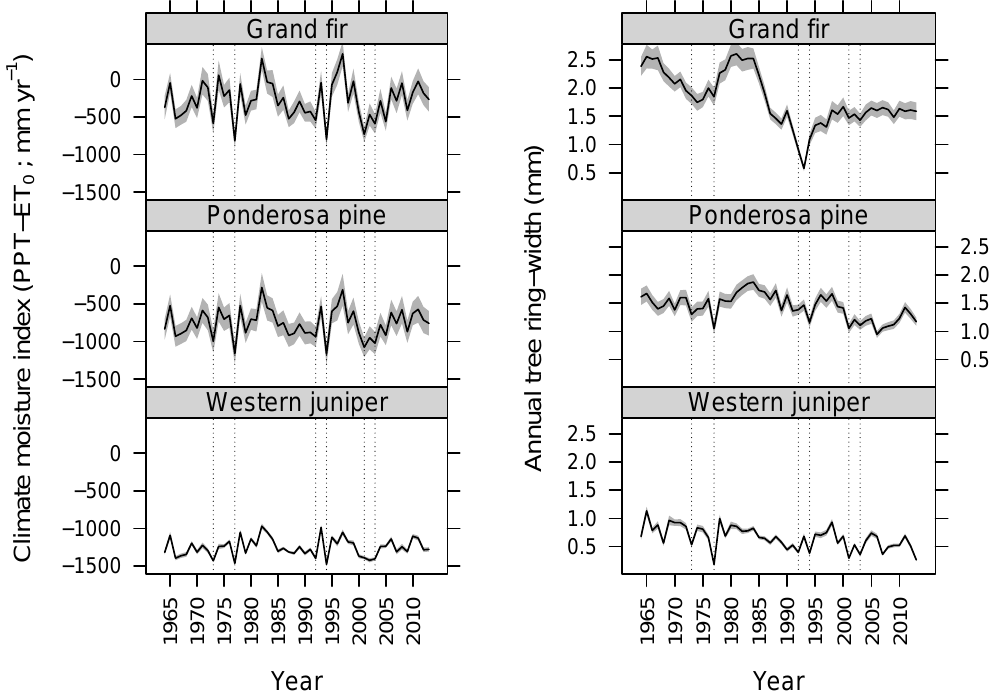
Figure 2. Growing-year climate moisture index (CMI gy ) from 1964 to 2013 averaged ( ± 1 SE) across sites ( n = 4) in three forest types (left panel). Average ( ± 1 SE) annual radial growth at breast height for grand fir ( n = 62), ponderosa pine ( n = 82), and western juniper ( n = 72) from 1964 to 2013, with trees pooled irrespective of site (right panel). In both panels the dotted vertical lines depicted 6 notably dry years (1973, 1977, 1992, 1994, 2001 and 2003) over the 50-year record. Table 2. Average ( ± 1SD) growing-year climate conditions from 1964 to 2013 for sites dominated by western juniper, ponderosa pine, and grand fir in the eastern Cascade Mountains, Oregon. The growing year extended from October of year t − 1 through September of year t . Climate variables include average daily temperature ( T gy ) , precipitation (PPT gy ), reference evapotranspiration (ET 0gy ) and climate moisture index (CMI gy = PPT gy ET 0gy ) calculated from monthly PRISM climate data (Daly et al., 2008). We averaged the climate time series for each of the four sites in a given forest type prior to calculating summary